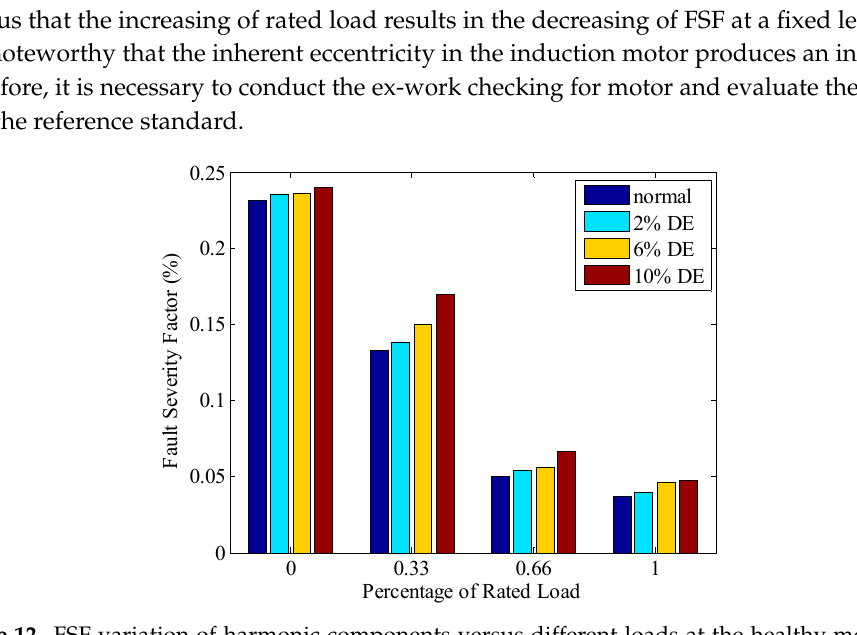
Figure 11. Variations of FSF for the induction motor at different loads: ( a ) healthy, ( b ) 2% DE, ( c ) 6% DE, ( d ) 10% DE.